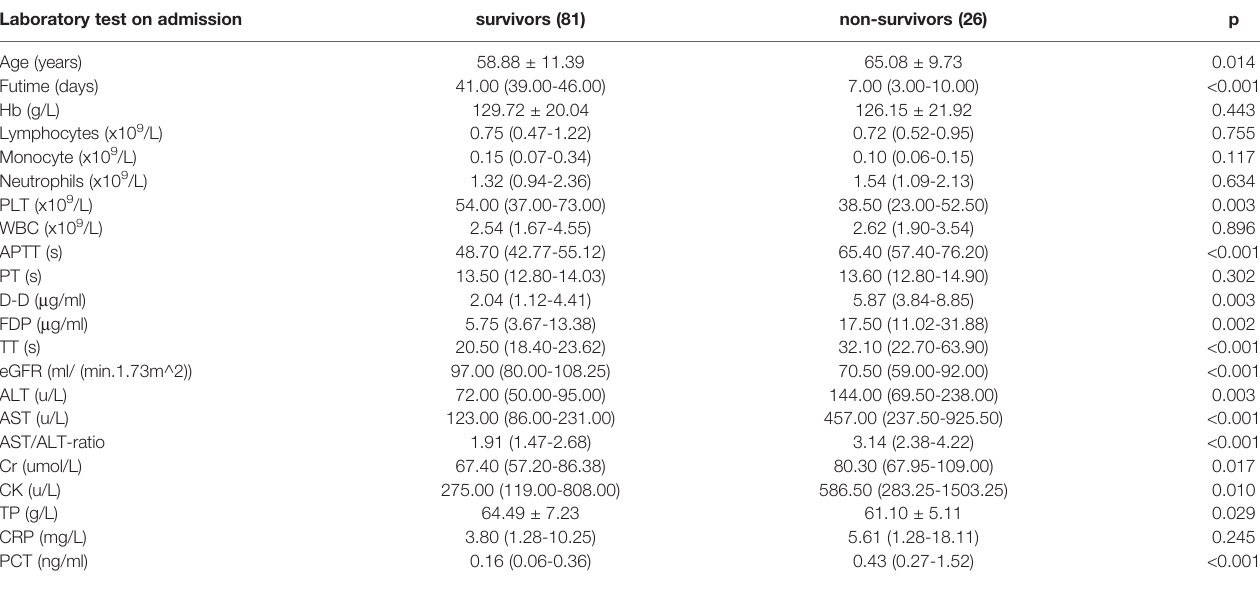
TABLE 5 | Difference of Laboratory results between survivors and non-survivors.